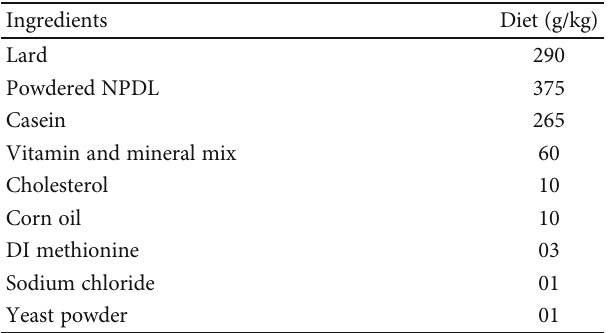
Table 1: High-fat diet composition.